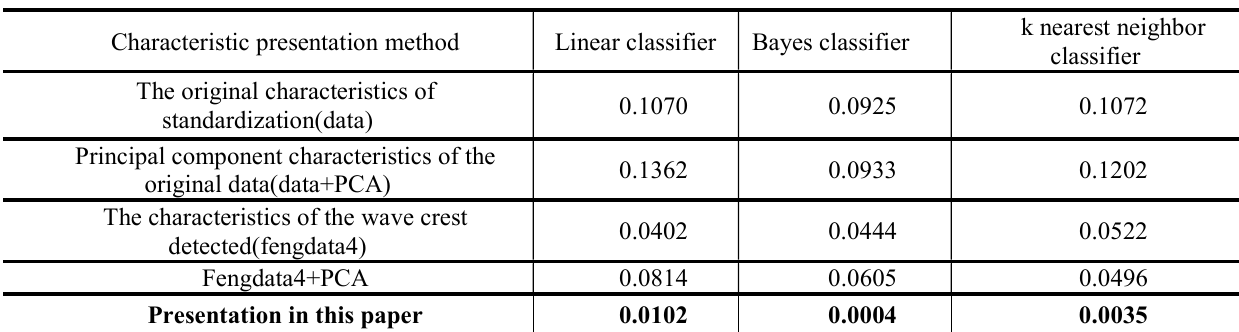
Table 2. The error rate of the recognition